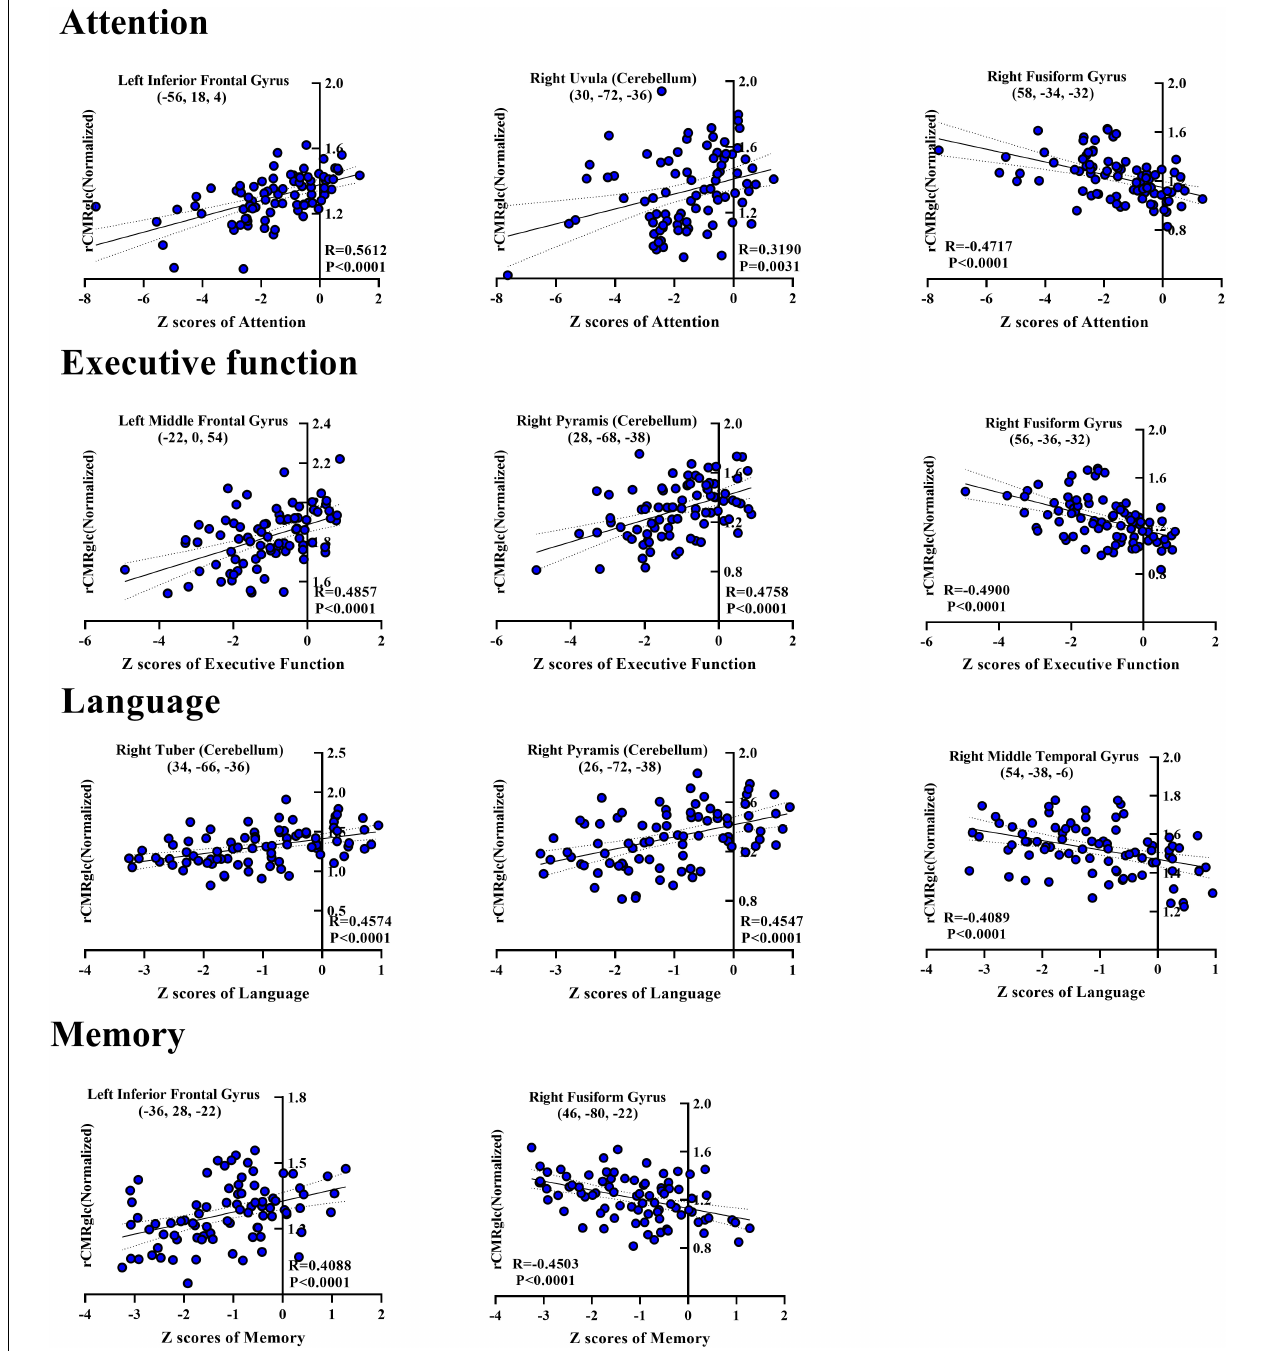
FIGURE 2 | Scatterplots showing correlations between Z -score of each cognitive domain and normalized regional glucose metabolic activities for the significantly correlated regions in the post-hoc analysis. Each blue-filled circle represents one patient with Z -score of specific cognitive domain and regional cerebral metabolic rate of glucose (rCMRglc) in certain brain region. R -value means the correlation coefficients. rCMRglc, regional cerebral metabolic rate of